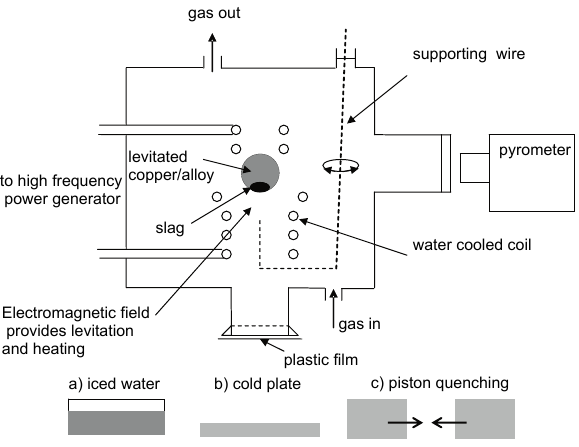
Figure 2. Schematic of levitation apparatus